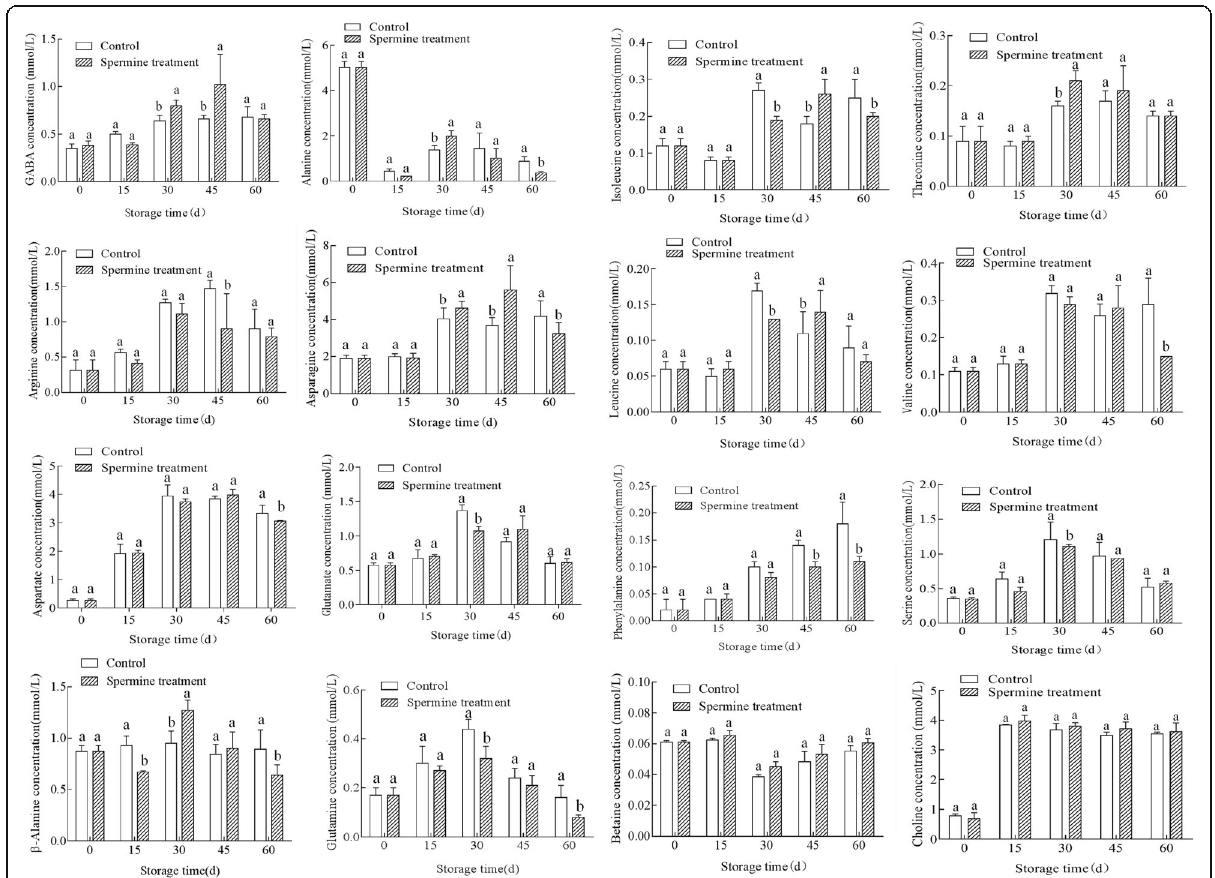
Fig. 4 Effect of exogenous spermine on the concentration of amino acids in cold-stored immature vegetable